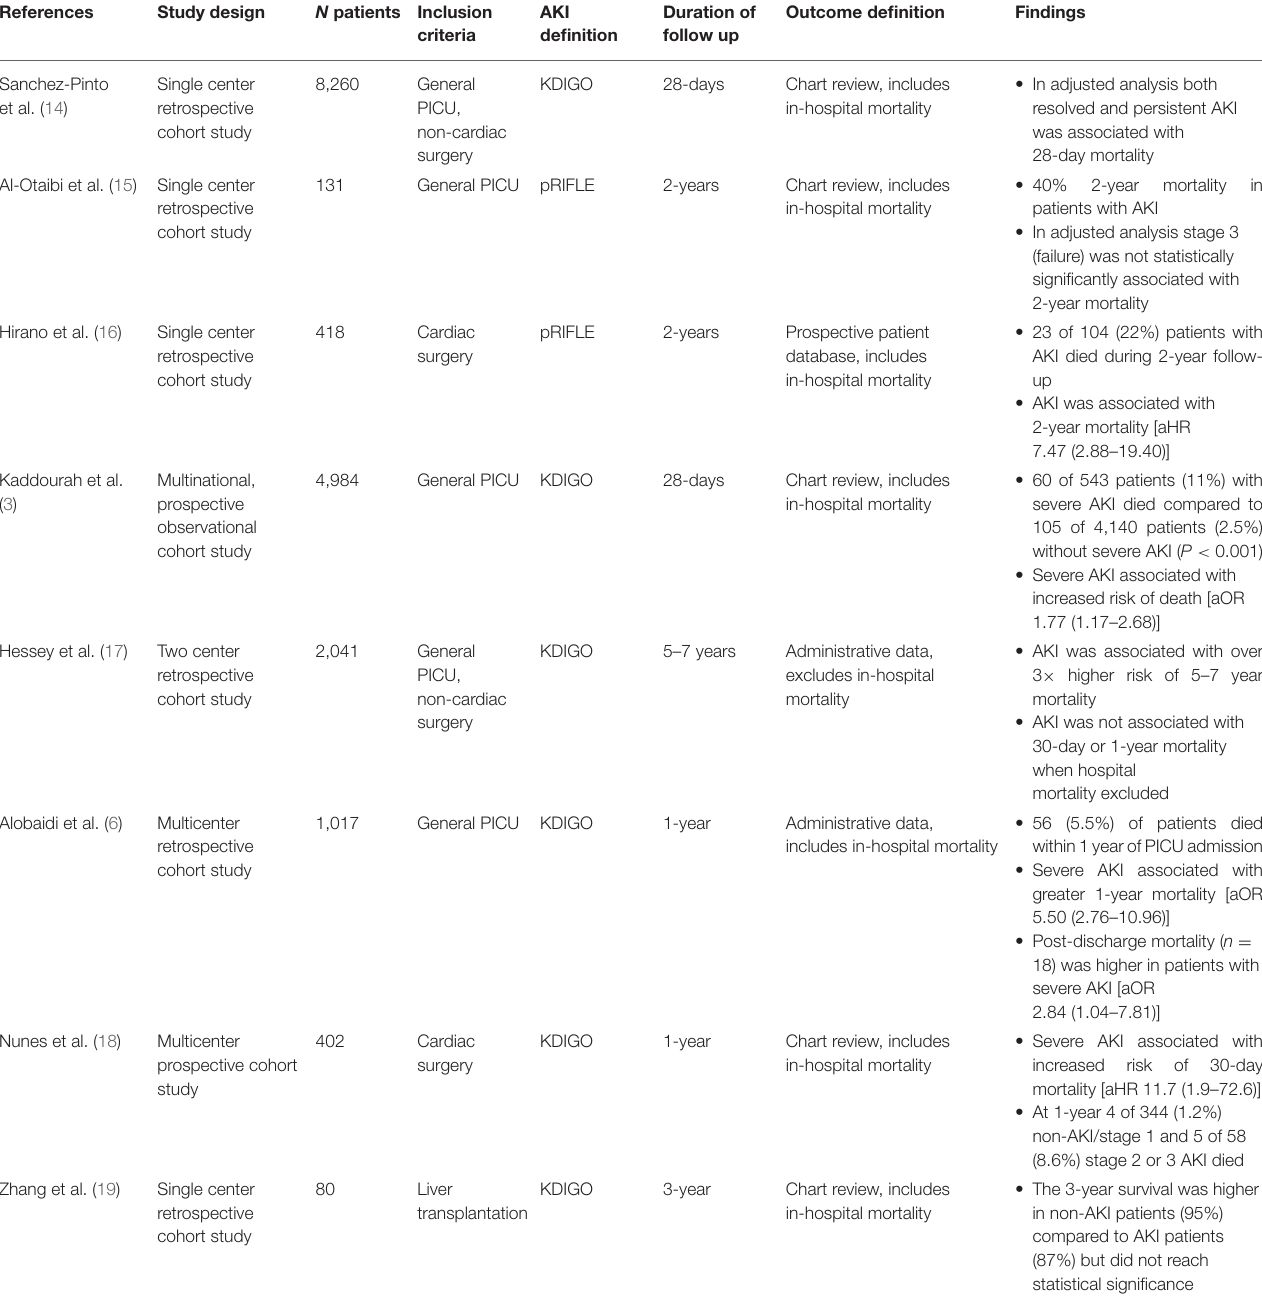
TABLE 1 | Summary of studies evaluating the association between AKI and mortality published over the past